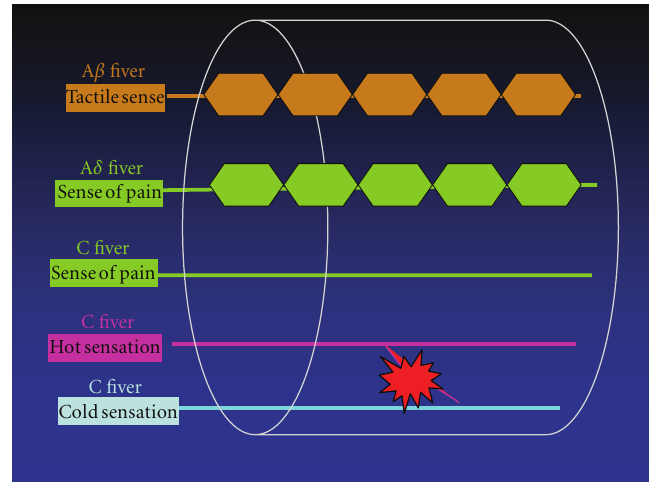
Figure 3: Ephapse between cold and warm sensation.